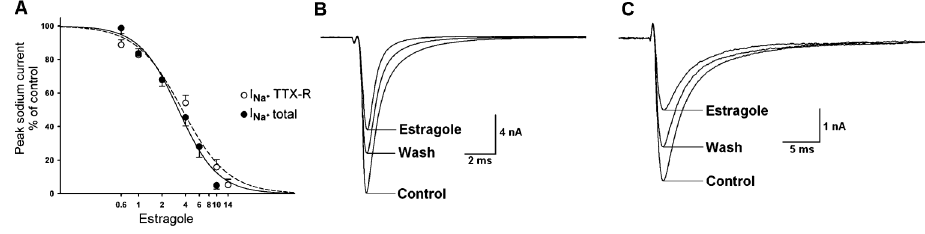
Figure 3. Estragole-induced inhibitory effect on total (INa + total) and on tetrodotoxin-resistant (INa + TTX-R) Na + current recorded in N 0 and N inf neurons. Panel A shows concentration-response curves (0.6-14 mM) for the effect of estragole on total Na + current and on TTX-R Na + current. Panels B and C show representative traces of the effects of 4 mM estragole on total ( panel B ) and TTX-R ( panel C ) Na + currents. There was partial recovery with washout. For INa + total, the number of experiments was n=4-12 and for INa + TTX- R, it was n=4-5 for each estragole concentration used.